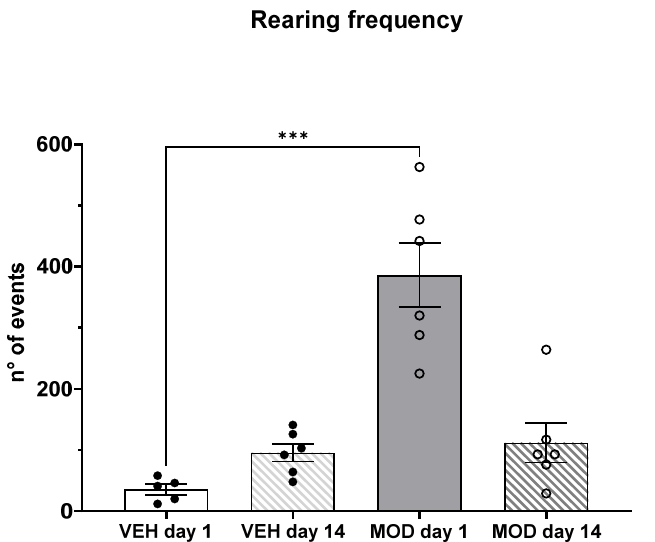
Figure 4. Rearing frequency at days 1 and 14 in the vehicle (VEH) and modafinil (MOD) groups of young male rats. Kruskal–Wallis test followed by Dunn post-hoc was used. Data are presented as the mean ± SEM; n = 5 or 6 per group. *** p < 0.001.